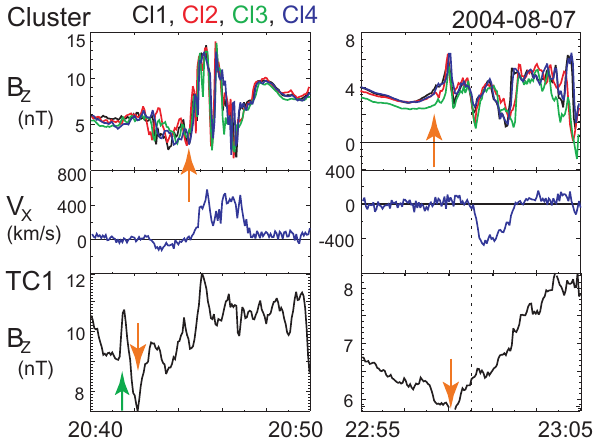
Fig. 2. Cluster B Z and V X and TC-1 B Z for 20:40–20:50 UT (left) and 22:55–23:05 UT (right), on 7 August 2004. The orange arrows show the B Z enhancements discussed in the text. The green arrow shows the estimated timing described in Sect. 4. The vertical line shows the 23:00 UT onset.